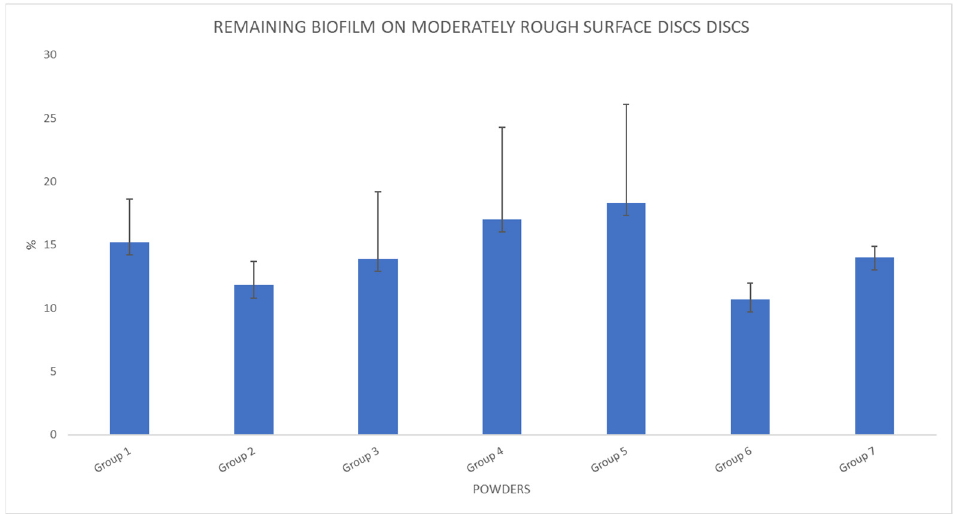
Figure 5. Percentage of remaining biofilm after decontamination of titanium discs with a moderately rough surface (MRS) by means of air abrasive unit delivering different powders.